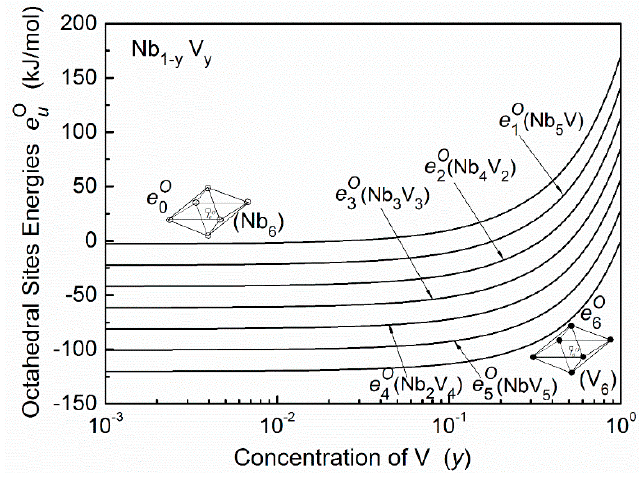
Figure 4. The octahedral site energy e O u of oxygen atoms in Nb–V alloys as a function of alloy composition. ( ○ —Nb atoms, ● —V atoms).